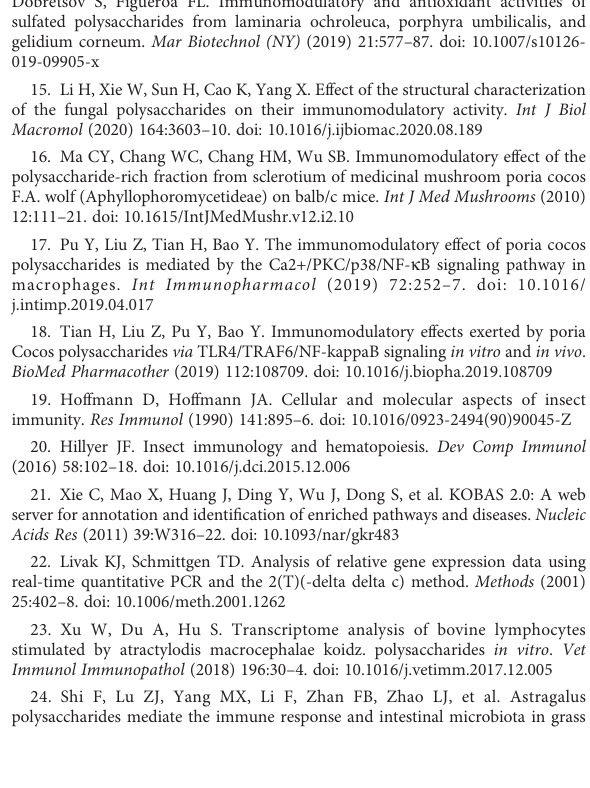
SUPPLEMENTARY FIGURE 1 Quality assessment of the transcriptome data. (A) Pie chart of reads distribution in different genomic regions. (B) Violin plot of the expression distribution of different samples. The bulky part of each sample represents the region with the most concentrated gene expression in the whole sample, the black rectangle encompasses the lower and upper quartiles, and the white dot represents the median. (C) The reads distribution in chromosomes for different samples. The abscissa represents different chromosomes; the ordinate represents the number of reads that mapped to the corresponding chromosome.